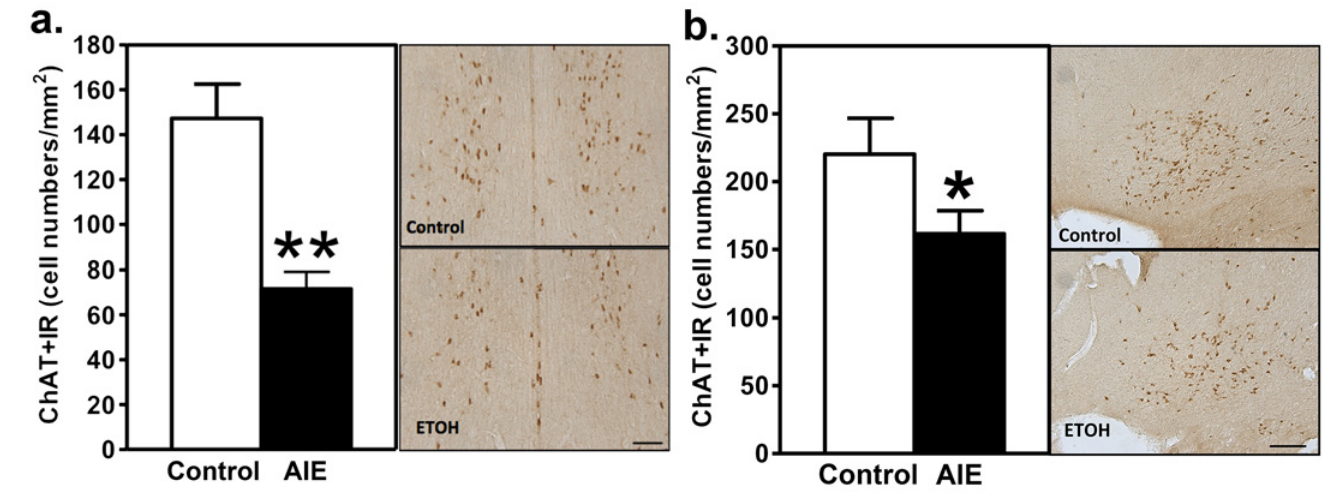
Fig 3. AIE decreases ChAT+IR in the basal forebrain in adulthood. AIE decreases ChAT+IR in the Ch1 and Ch2 nuclei of the basal forebrain of adult rats (a). Left Panel — the cell density of ChAT+IR is significantly decreased in the Ch1 and Ch2 nuclei at 0.70 ~ 0.20 mm from bregma 25 days after AIE, ** p < 0.01. Right Panel — representative photomicrography ChAT+IR neurons in the Ch1 and Ch2 nuclei from a control animal (Control), and an AIE-exposed animal (ETOH). AIE decreases ChAT+IR in the Ch3 and Ch4 nuclei of the basal forebrain of adult rats (b). Left Panel — the cell density of ChAT+IR is significantly decreased in the Ch3 and Ch4 nuclei at 0.48 ~ 0.40 mm from bregma 25 days after AIE, * p = 0.046. Right Panel — representative photomicrography ChAT+IR neurons in the Ch3 and Ch4 nuclei from a control animal (Control), and an ethanol-exposed animal (ETOH). Scale bar = 50 μ m.